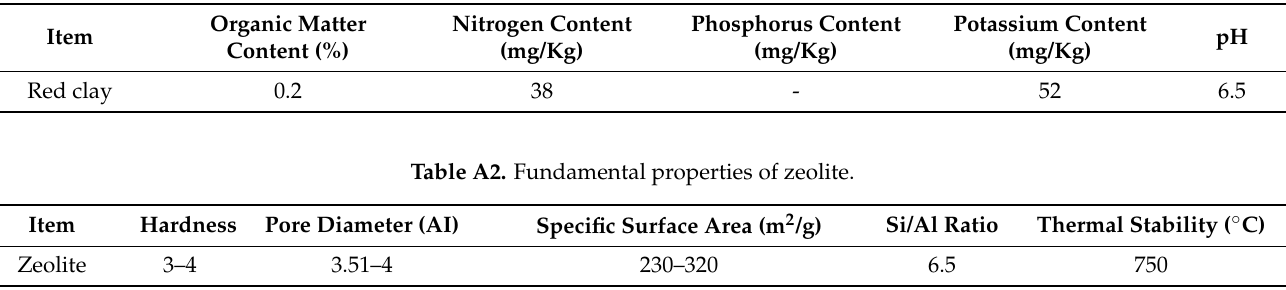
Table A1. Fundamental properties of red clay.